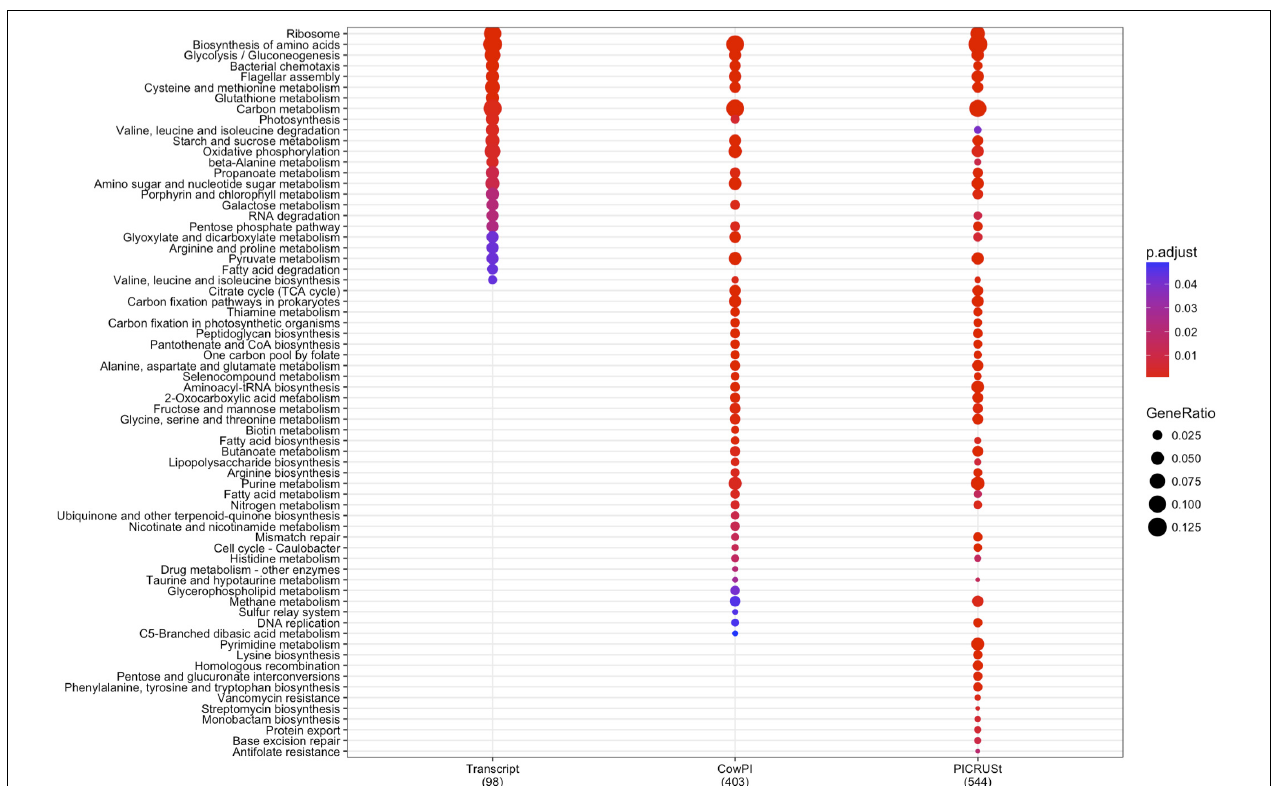
FIGURE 3 | Significantly over-represented KEGG functional hierarchies by differentially abundant KEGG orthologs (KOs) between 2 and 4 h samples for each dataset. Circle size represents KO counts within that pathway in proportion to the total number of differentially abundant KOs, while red coloration represents lower P value and therefore higher significance. Numbers in parentheses are the total number of KOs contributing to the